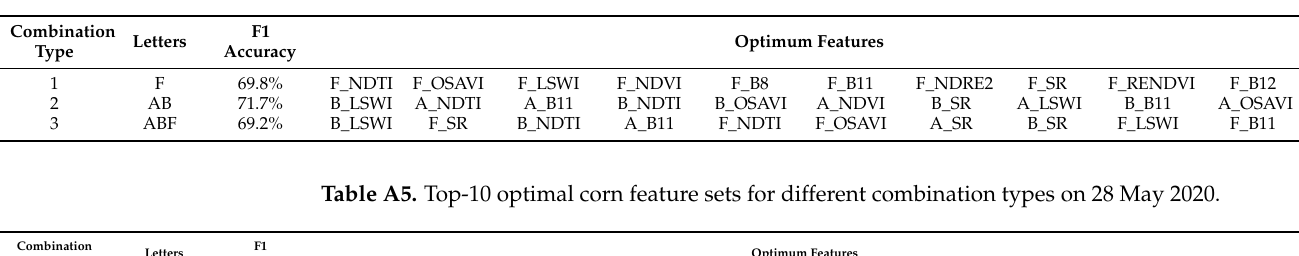
Table A4. Top-10 optimal corn feature sets for different combination types on 13 May 2020.